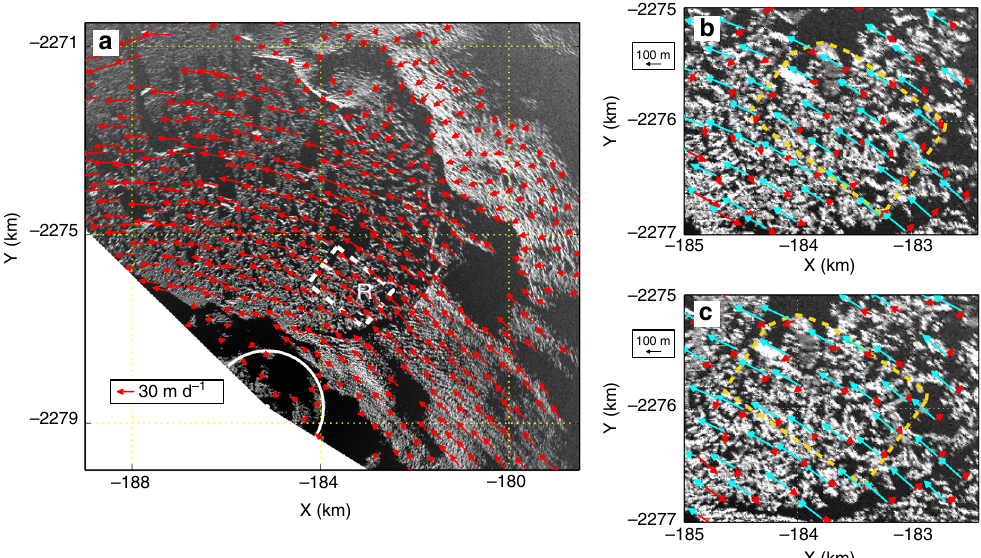
Fig. 6 Feature tracking of TRI amplitude image pairs using the Open Source Computer Vision Library (https://opencv.org/). a Feature tracking velocities of a TRI amplitude image pair acquired at 12:00 7 June 2016 and 12:00 8 June 2016 (background image). Vectors within the white arc area show velocities at stationary or slow-moving points. We use their RMS as a measure of the uncertainty for feature tracking: 0.24 and 0.04 m d − 1 for two orthogonal directions. Dashed rectangle R marks the area used for mélange thinning estimates in Fig. 5. b Feature tracking displacements from 12:00 7 June 2016 to 12:00 13 June 2016 (background image). Cyan arrows show displacements between two TRI scans, red arrows show displacements after subtracting the median displacement within the range of the map. Dashed box corresponds to the convex hull in Fig. 5e. c Feature tracking displacements from 12:00 13 June 2016 to 12:00 19 June 2016 (background image). Cyan and red arrows denote the same as b , dashed box corresponds to the convex hull in Fig.